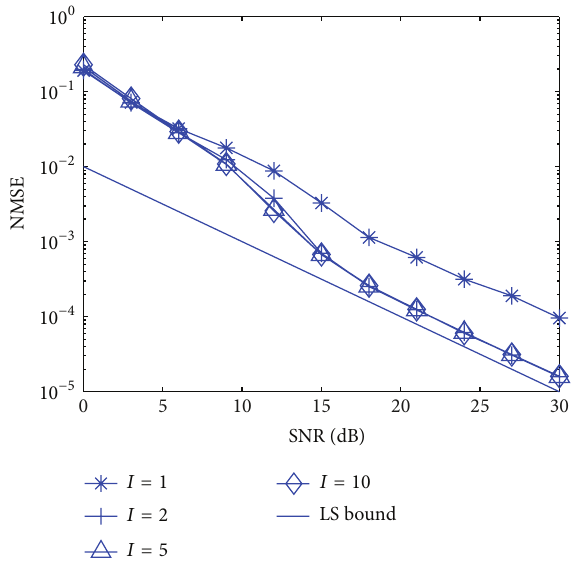
Figure 9: NMSE comparisons of ML-LM iteration for different numbers of